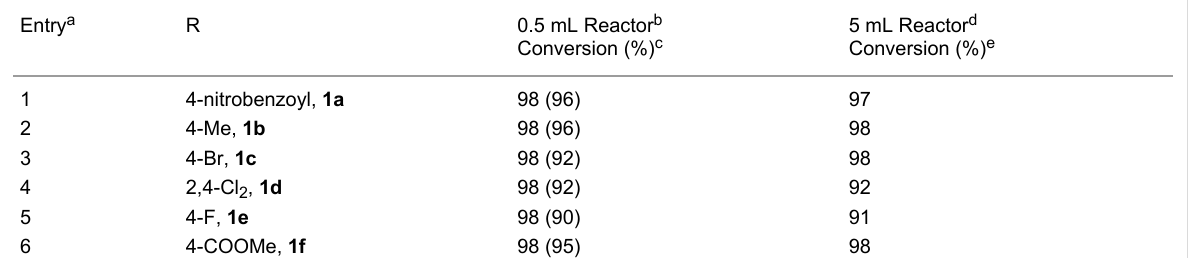
Table 2: Scope of the reaction (see Scheme 2).